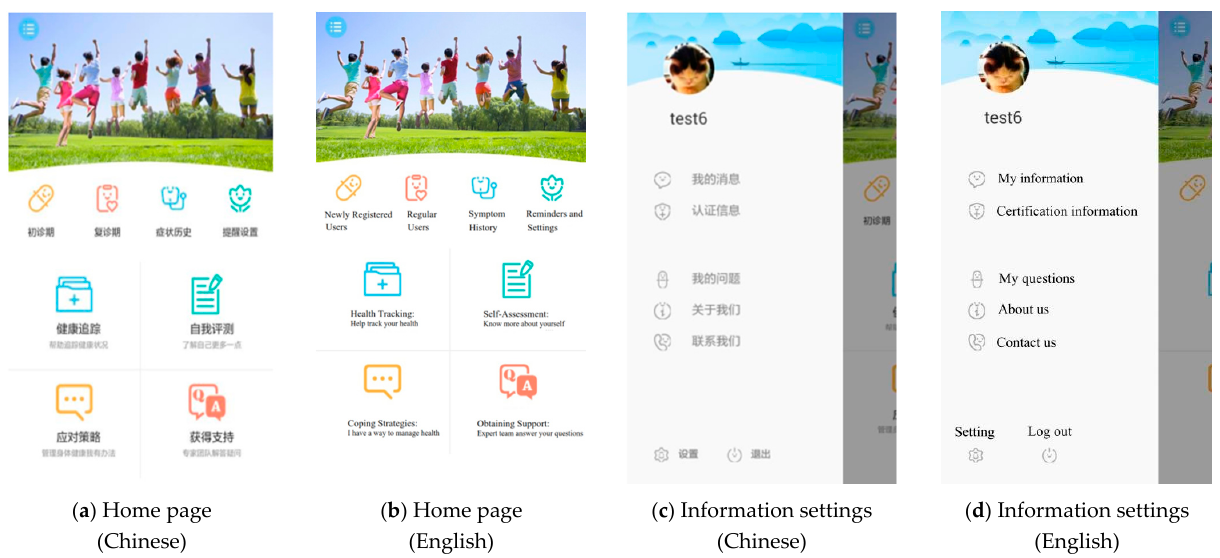
Figure 3. Screenshot of the home page and information settings.